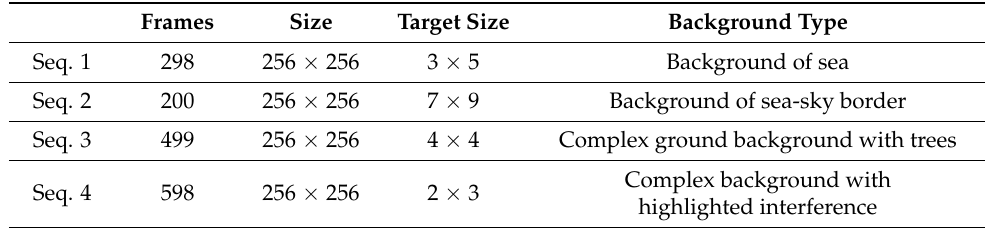
Table 1. Detailed description of test